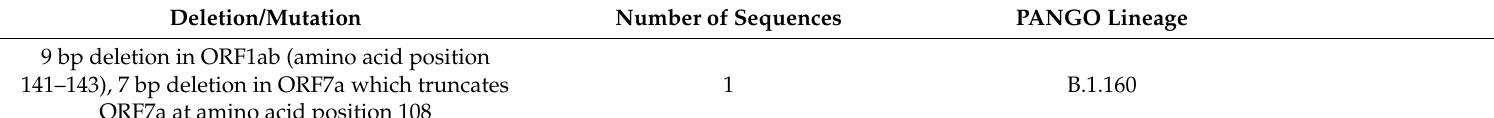
Table 1. Deletion and/or amino acid substitutions identified in the recovered SARS-CoV-2